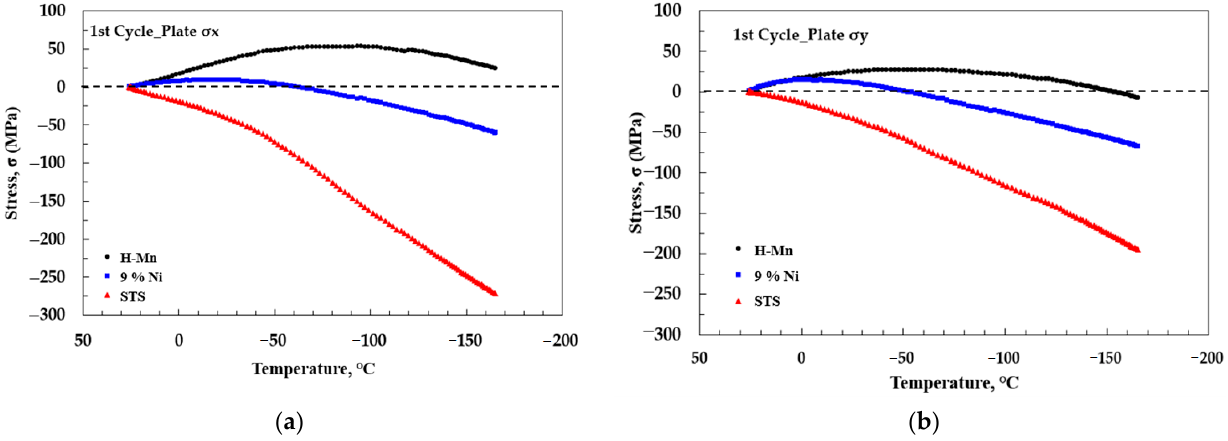
Figure 6. Stress behaviors of ( a ) σ x and ( b ) σ y with the three types of cryogenic steels in the 1st thermal cycle of the experiment.